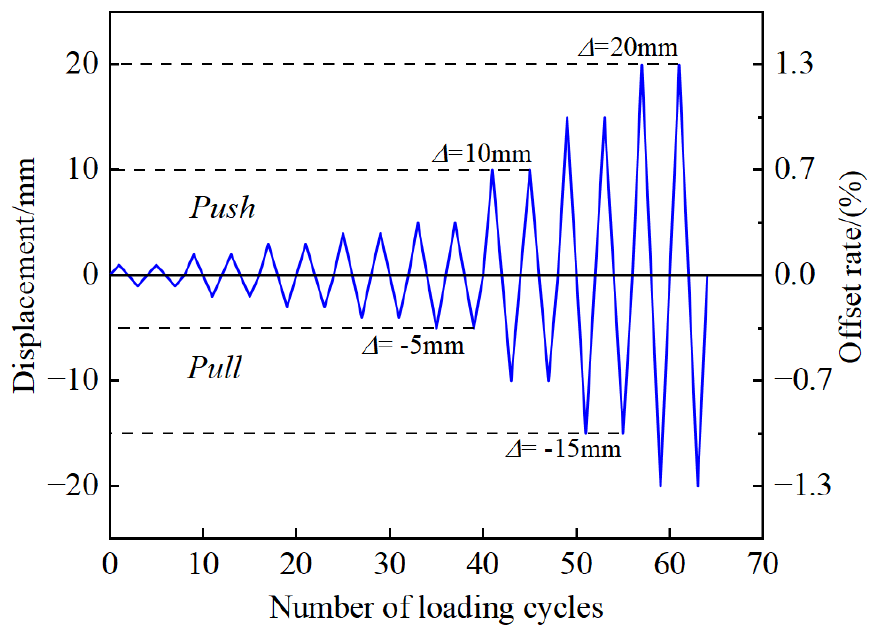
Figure 12. Loading regime.